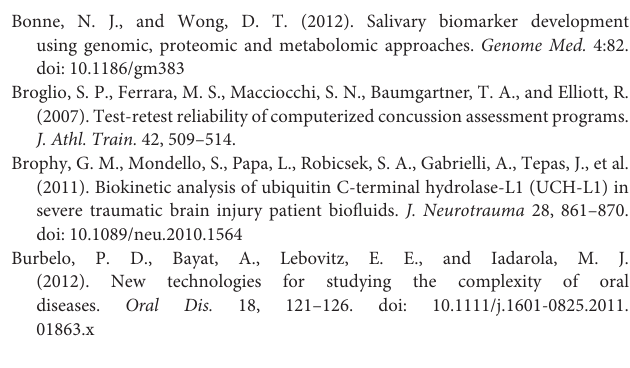
FIGURE S1 | Human miRNA tissue atlas. Expression of the 5 miRNAs in different human tissue. FIGURE S2 | Boxplot of the 5 candidate miRNA biomarkers at early and late time points. Boxplot comparing the relative expression of the 5 microRNAs at different time points, 48–72 h and > 120 h of concussed athletes to non-concussed athletes. ANOVA test was used to show significant results ( p < 0.05) across groups. TABLE S1 | List of biomarkers analyzed with the Proseek proximity extension assay. TABLE S2 | t -Test for the 65 proteins detected in saliva of non-concussed and concussed athletes. TABLE S3 | Area under the curve (AUC) of representative TBI